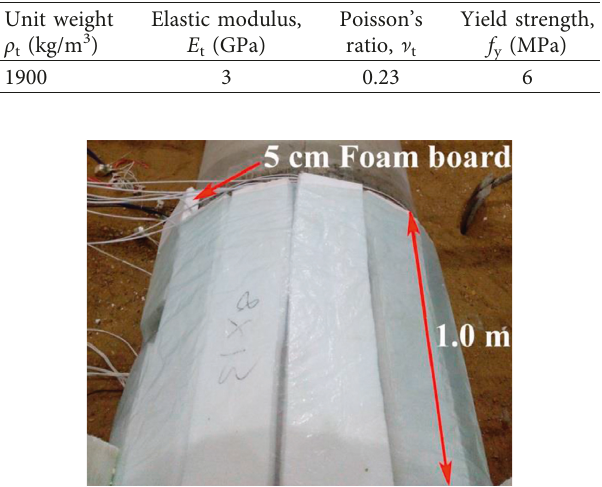
Figure 4: Shock absorbing layer. Table 5: Mechanical properties of foam